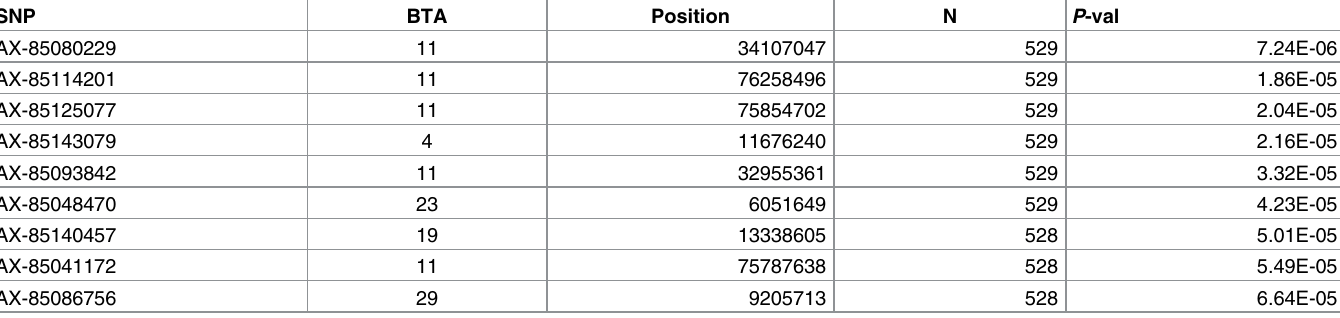
Table 2. Significant SNPs obtained in the GWA study for milk yield in 529 Italian Mediterranean buffalo. SNP